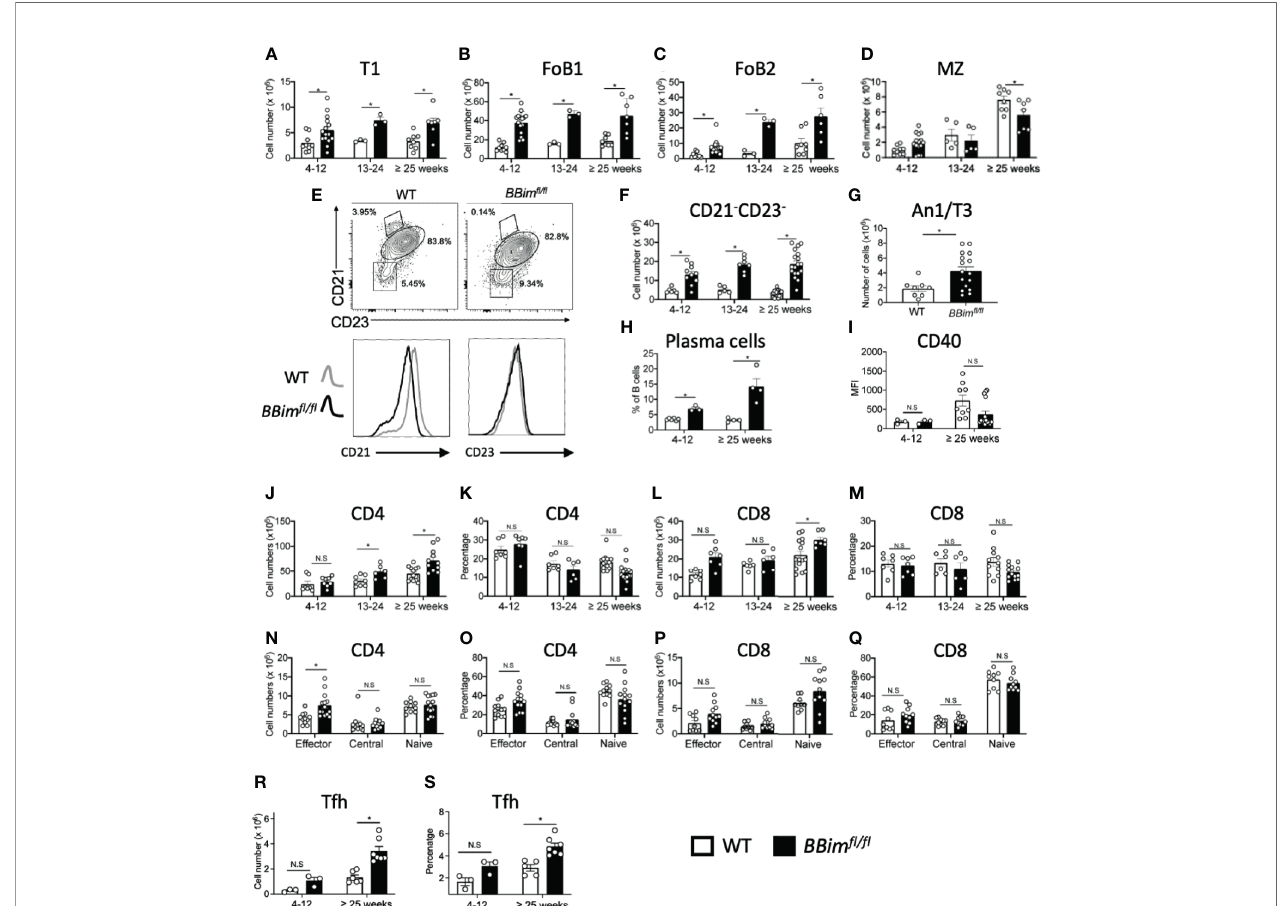
FIGURE 2 | BBim fl / fl mice have expanded effector B and T cell populations in the spleen. Splenic B and T cell subpopulations were identi fi ed by FCM using established cell surface markers described in materials and methods. (A – D) Numbers of T1, FoB1, FoB2 and MZ plus pre-MZ B cells subsets in BBim fl / fl and WT mice in the indicated age groups. (E) Representative FCM plots showing gating strategy to quantify CD21 and CD23 double negative (DN) B cells within total B cells (top panels) and histograms displaying CD21 and CD23 expression showing reduced CD21 expression in B cells from BBim fl /f l relative to WT mice (bottom panels). (F) Numbers of CD21 - CD23 - DN B cells in BBim fl / fl and WT mice. (G) Numbers of anergic (An1/T3) B cells. (H) Numbers of plasma cells. (I) MFI values of CD40 in B cells (J – Q) Quanti fi cation of splenic CD4 and CD8 T cell populations on CD3+ gated cells in the ≥ 25 week old BBim fl / fl and WT mice. Representative graphs displaying (J) CD4 T cell numbers and (K) proportions and (L) CD8 T cell numbers and (M) proportions. (N) Cell numbers and (O) proportions of CD4 effector, central memory and naïve CD4 subsets. (P) CD8 T cell numbers and (Q) proportions of CD8 effector, central memory and naïve T cells. (R) Cell numbers and (S) percentages of Tfh cells. Data is representative of >3 independent experiments. Not signi fi cant (N.S) P > 0.05, *P ≤ 0.05, calculated by Students T- test and Mann- Whitney non-parametric